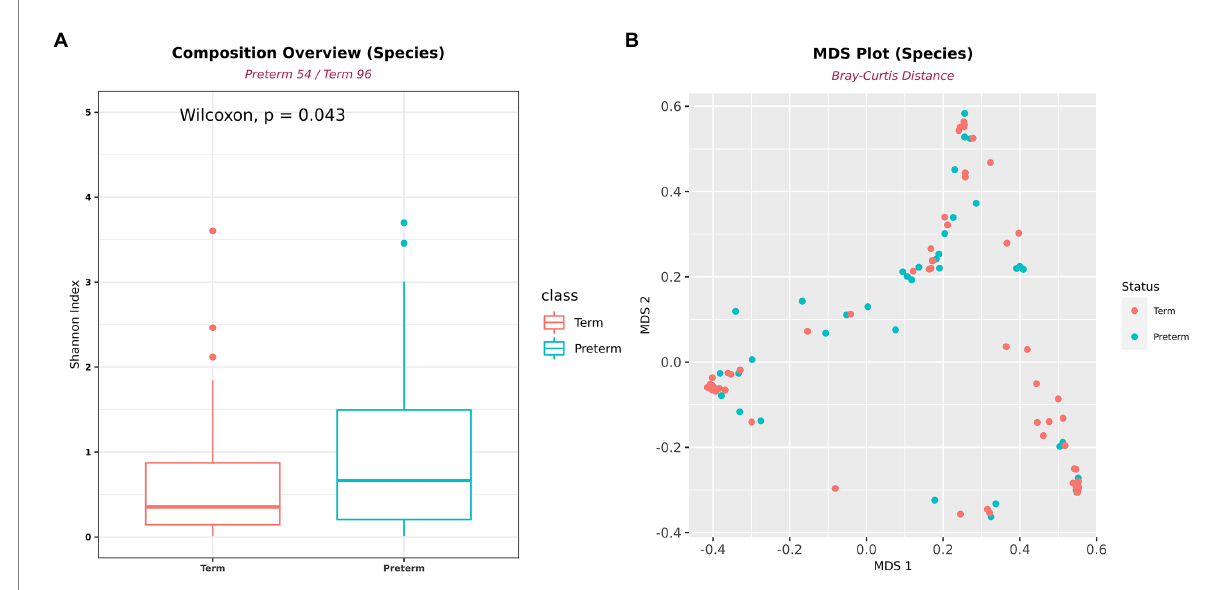
FIGURE 3 Differences in alpha- and beta-diversity between PTB and TB groups. (A) Shannon’s alpha diversity was significantly higher in the PTB group (PTB, n = 54; TB, n = 96). (B) Multidimensional scaling plot. Boxes show median and interquartile ranges, and whiskers extend from minimum to maximum values.